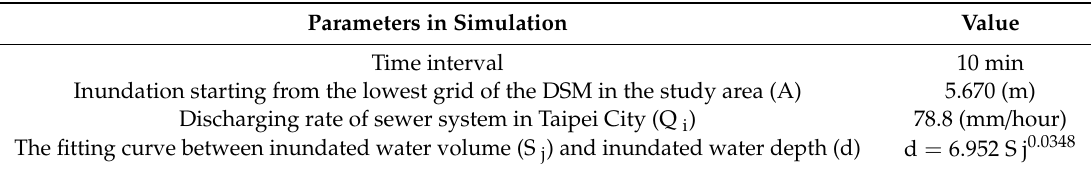
Table 3. The parameters of the rainfall runo ff